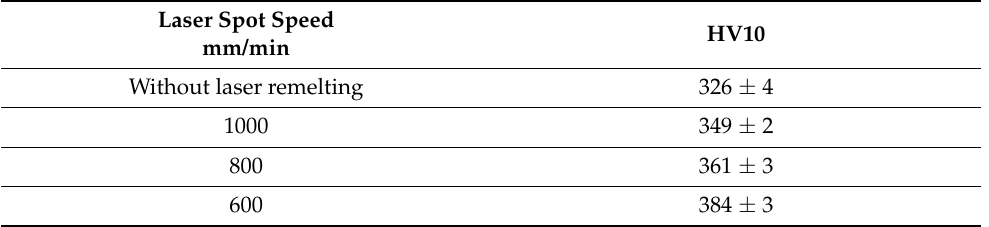
Table 2. Vickers microhardness of the Cr 3 C 2 -25(Ni20Cr) cermet coatings on the Al7075